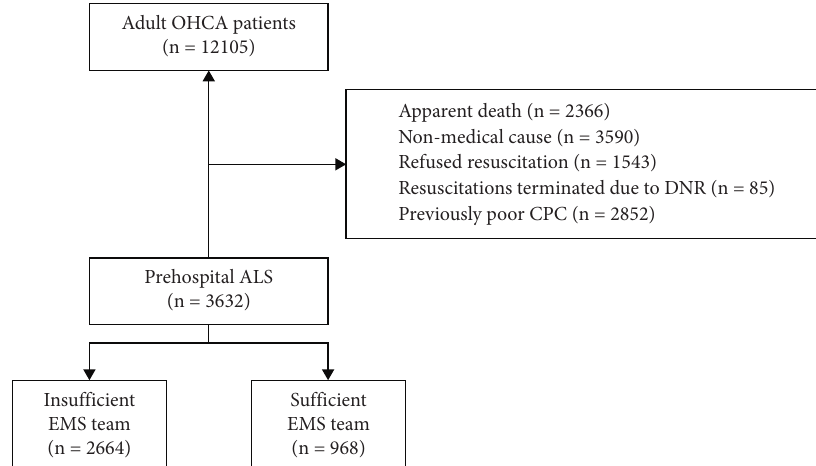
Figure 1: Flowchart showing study inclusion and exclusion criteria. OHCA, out-of-hospital cardiac arrest; DNR, do not resuscitate; CPC, cerebral performance category; ACLS, advanced cardiovascular life support; EMS, emergency medical Table 1: Baseline characteristics of patients according to the EMS team personnel before and after propensity score matching. Before propensity score matching a